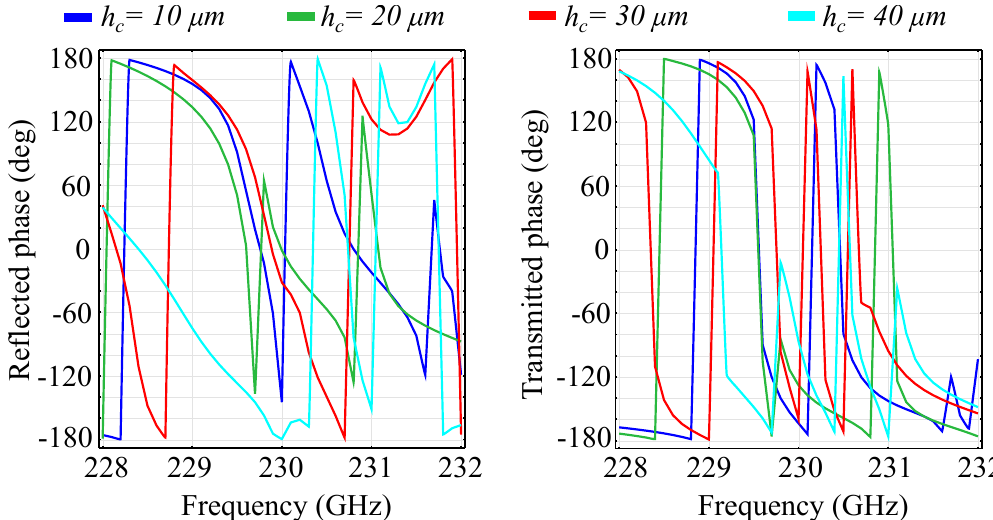
Figure 7. Associated phase for the reflected and transmitted waves, for fixed ring-cone height ( h c ) values in the silica glass substrate